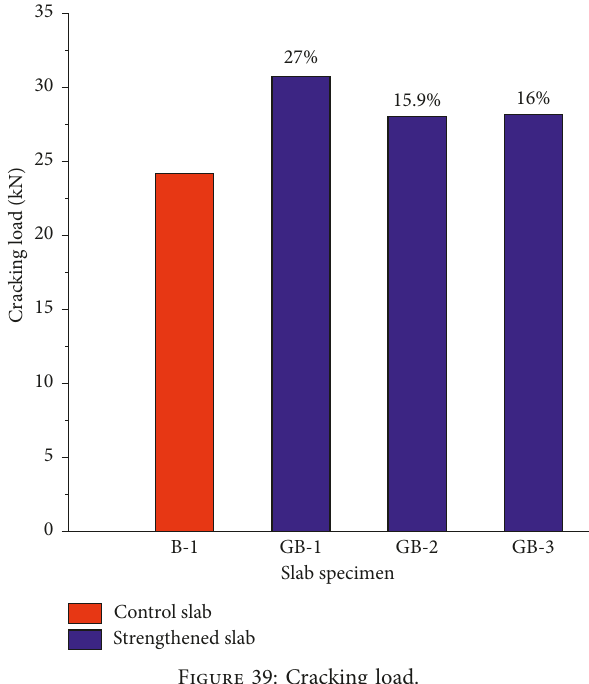
Figure 39: Cracking load.